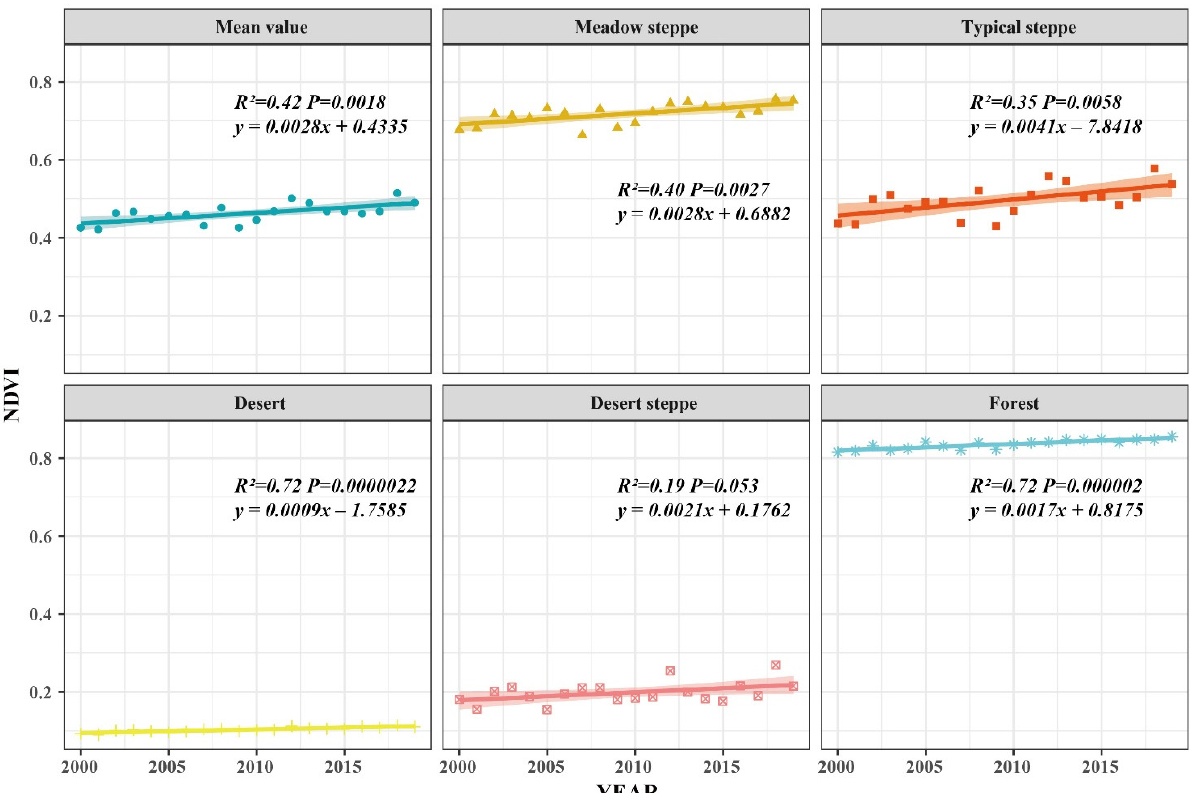
Figure 3. Interannual variation of NDVI by vegetation types in Inner Mongolia from 2000 to 2019.